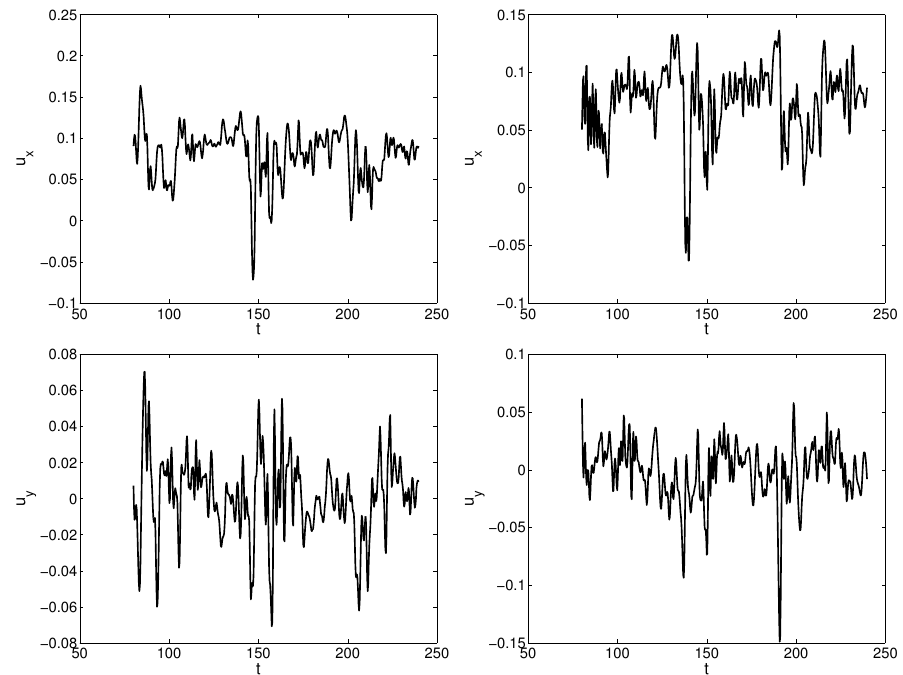
Figure 4. One-blade turbine case: temporal evolution of the streamwise ( top ) and normal ( bottom ) velocity fields, u x and u x for points P ( x 1 , y 1 ) = ( 0, − 4 ) ( left ) and P ( x 1 , y 1 ) = ( 2.8, − 2 ) ( right ) (see the computational domain in Figure